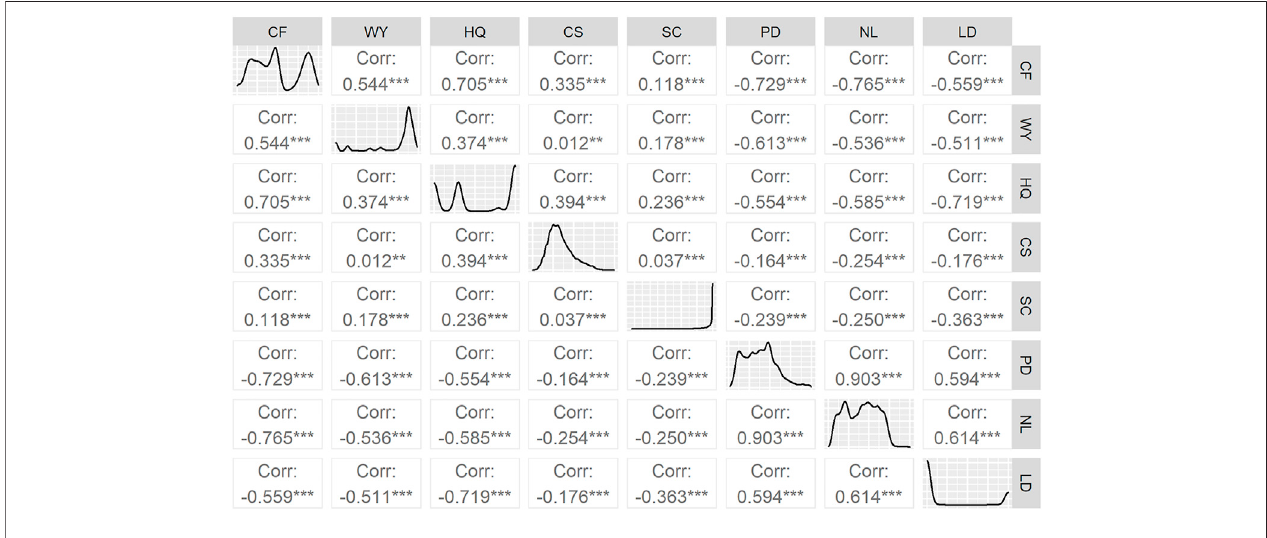
FIGURE 4 | Correlation matrix.